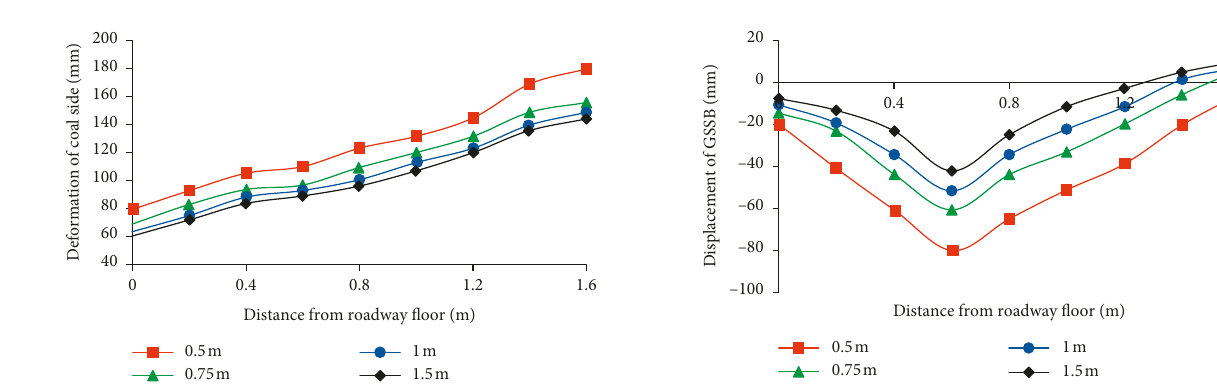
Figure 19: Displacement of roadway coal side. Figure 20: Displacement of